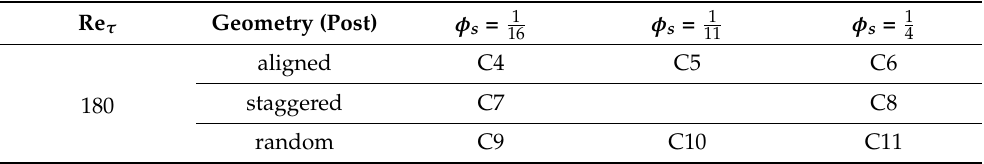
Table 4. Reynolds numbers, post pattern, solid fraction, and case notation in the post type, with name cases from C4 to C11.